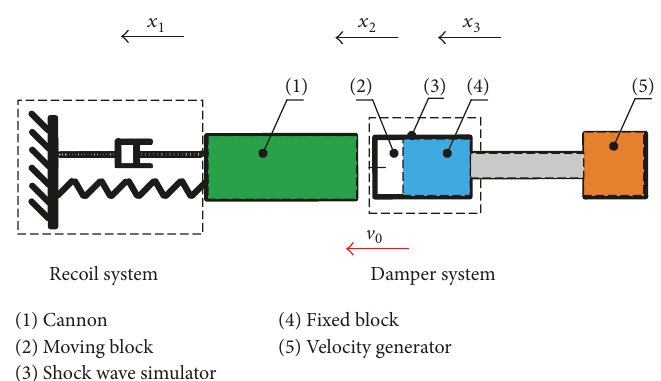
Figure 5: Coupling model for the high-power shock simulation